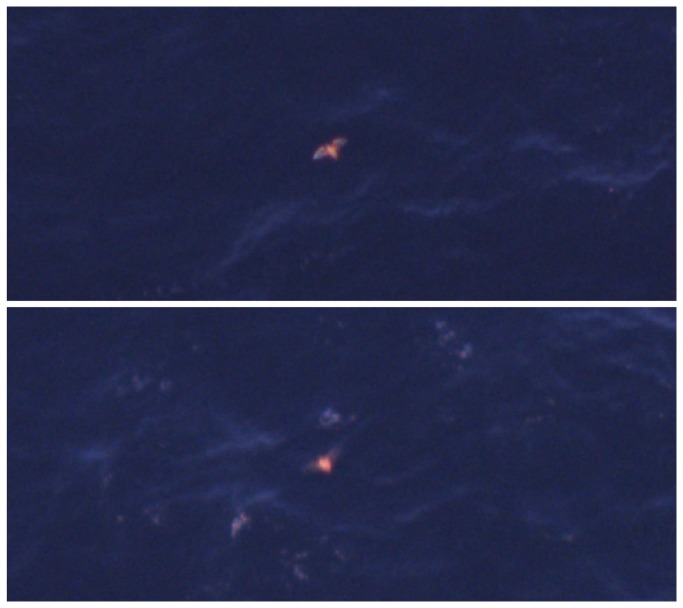
Examples of eastern red bats recorded in high definition aerial footage.Footage recorded from 610 m above sea level with a resolution of 2 cm ground spatial resolution.